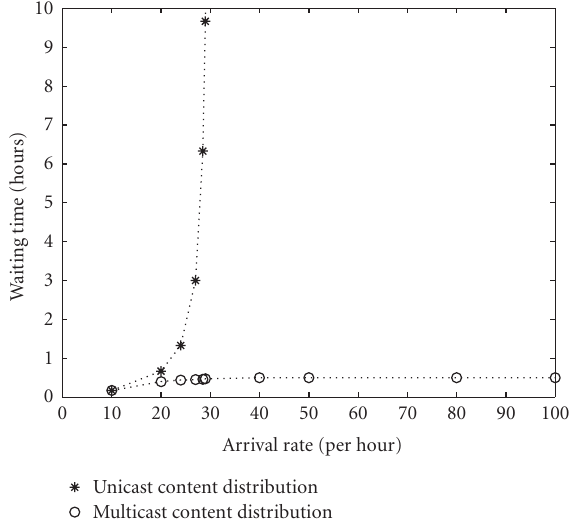
Figure 4: The waiting time in hours, as a function of the arrival rate per hour to the